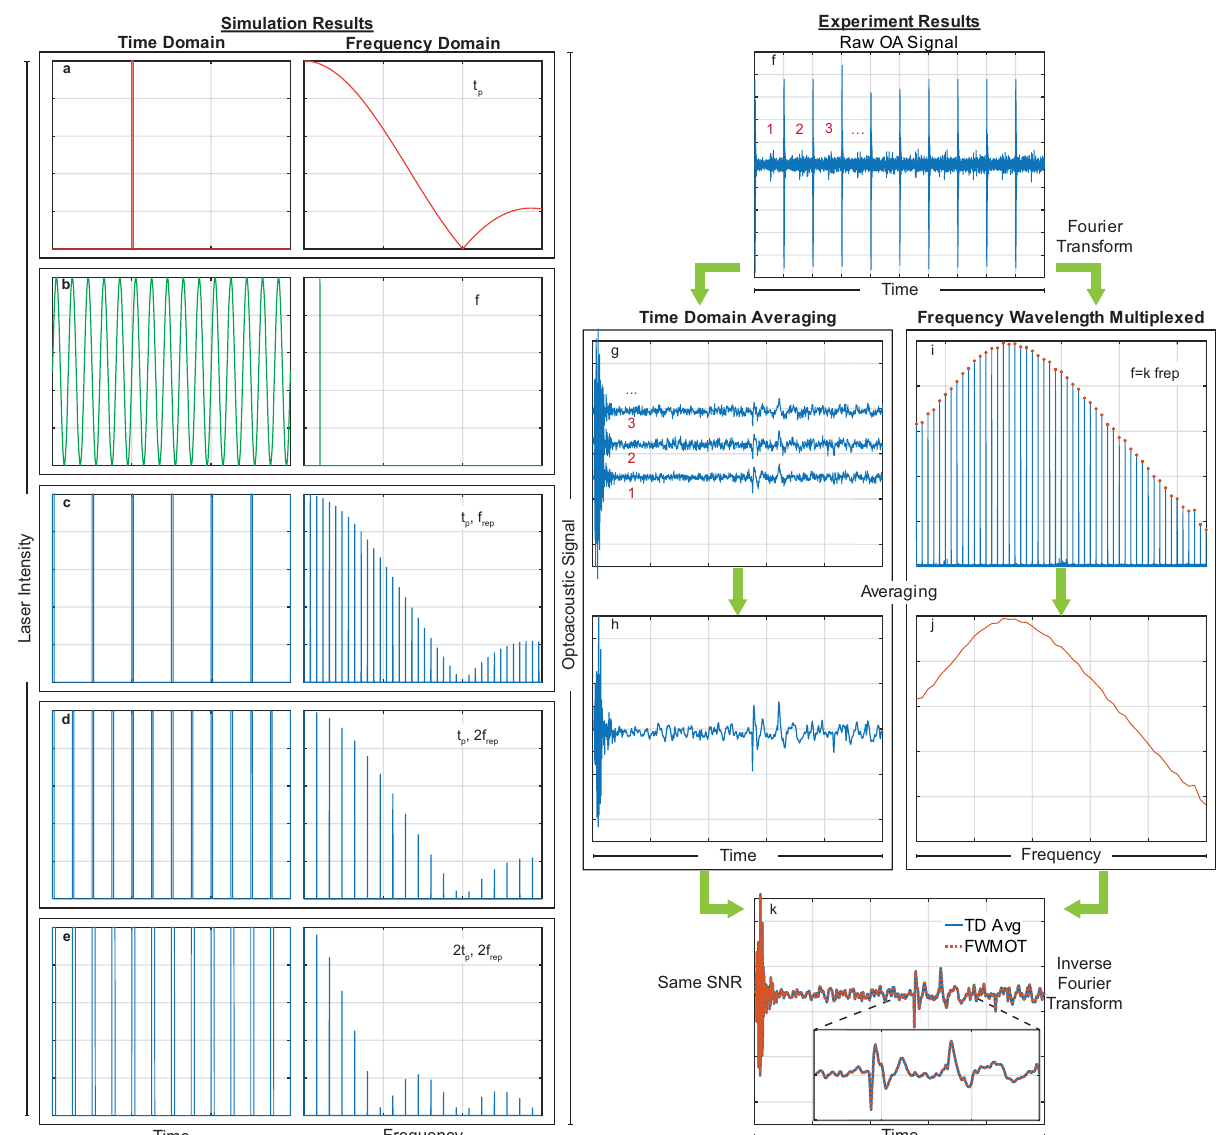
Fig. 1 | The signal processing algorithms used in Frequency Wavelength Mul- tiplexedOptoacousticsatasinglewavelength.a Asingleexcitationlightpulseof t p duration in TD(left) and a continuous spectrum offrequencies in FD(right). b A sinewaveoffrequency f inTDand FD,continuous wave in TD and asingle discrete peak in FD. c A train of pulses with pulse duration t p and repetition rate f rep in TD and FD. Many discrete pulses in TD and many discrete frequencies in FD with the same envelope as a single pulse of t p duration in a . d A train of pulses with pulse duration t p and repetition rate 2 f rep in TD and FD. Twice as many pulses in TD but halfthenumberofdiscretefrequenciesinFDcomparedto c . e Atrainofpulseswith pulse duration2 t p and repetition rate 2 f rep inTDand FD. Asmanypulses in TDand discretefrequenciesinFDasin d butnowfollowingadifferentenvelopethan( a